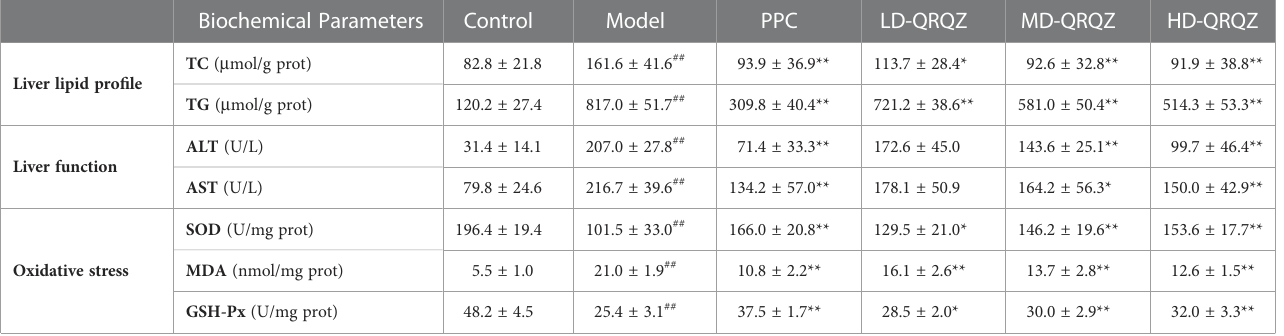
TABLE 1 Changes in physiological indices, oxidative stress factors after QRQZ treatment. Biochemical Parameters